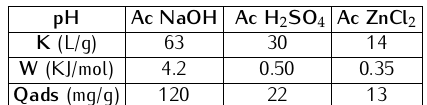
Table 3. Values of parameters of Fowler-Guggenheim model of Chromium adsorption over different activated